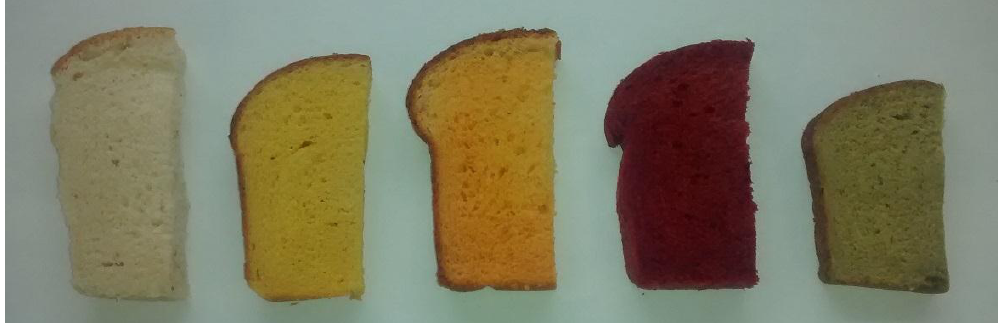
Figure 4. Physical appearance and size comparison of the baked breads. From left to right: Plain, Carrot, Tomato, Beetroot and Broccoli.